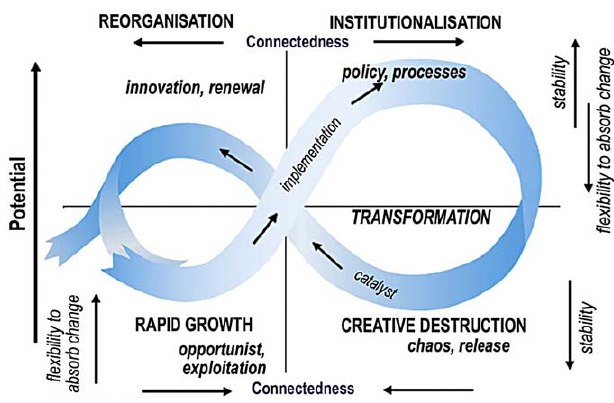
Figure 2. The Adaptive Cycle